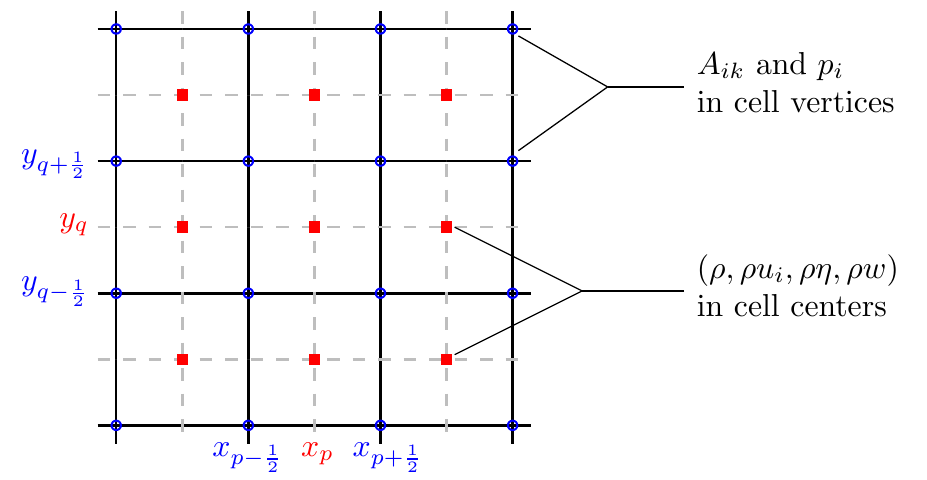
Figure 2. Schematic of the computational domain featuring the grid points and the staggered dual grid points. Red squares are barycenters and blue circles are the vertexes of the computational